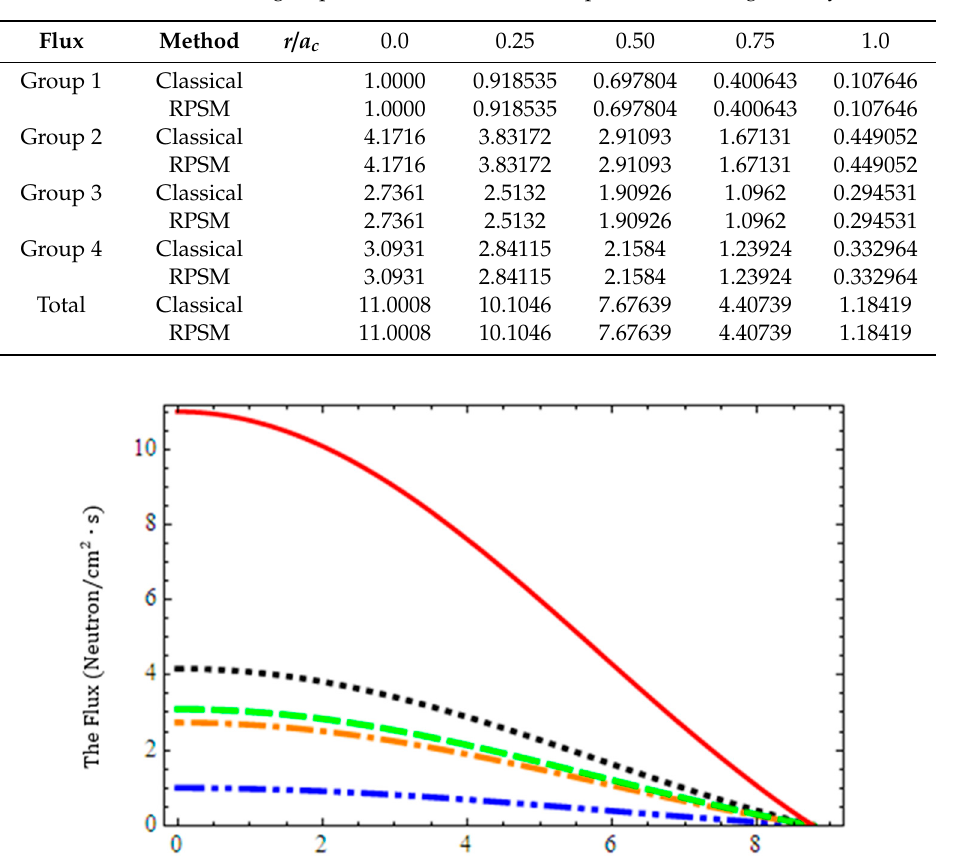
Table 12. The four groups fluxes and total flux in spherical reactor geometry.